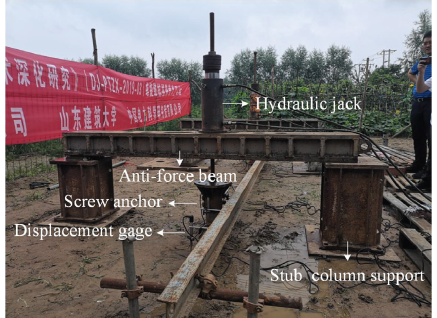
Figure 2: Test of screw anchor.